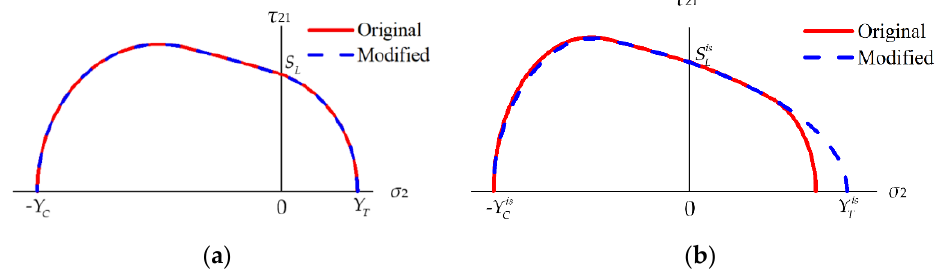
Figure 6. F IFF – θ relation under simple stress states for the ply embedded in a multidirectional